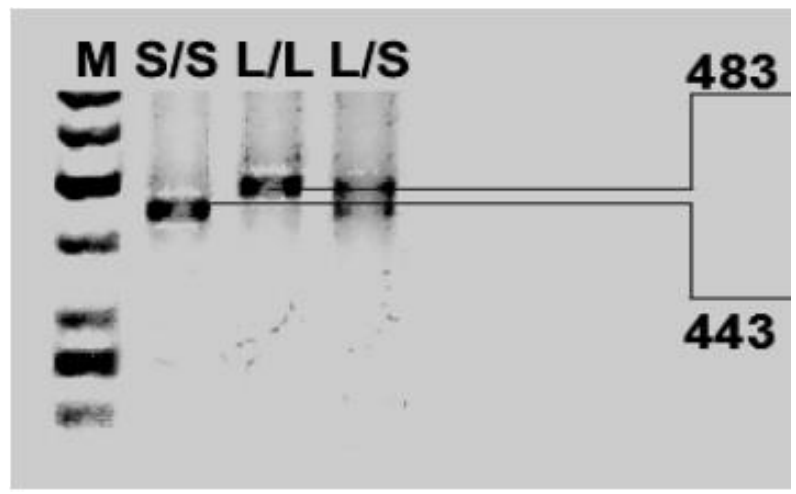
Figure 2. Photo of digested DAT1 PCR products. The results are labeled by genotype: 10/10 (L/L) 483 bp only; 10/9 (L/S) 483 and 443 bp; and 9/9 (S/S) 443 bp only.